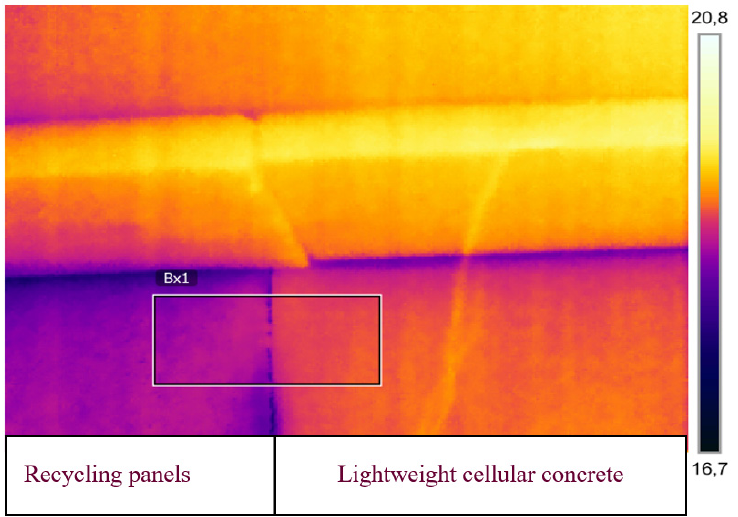
Figure 19. Thermal imaging photo of the wall insulated with recycling material and with lightweight cellular concrete.